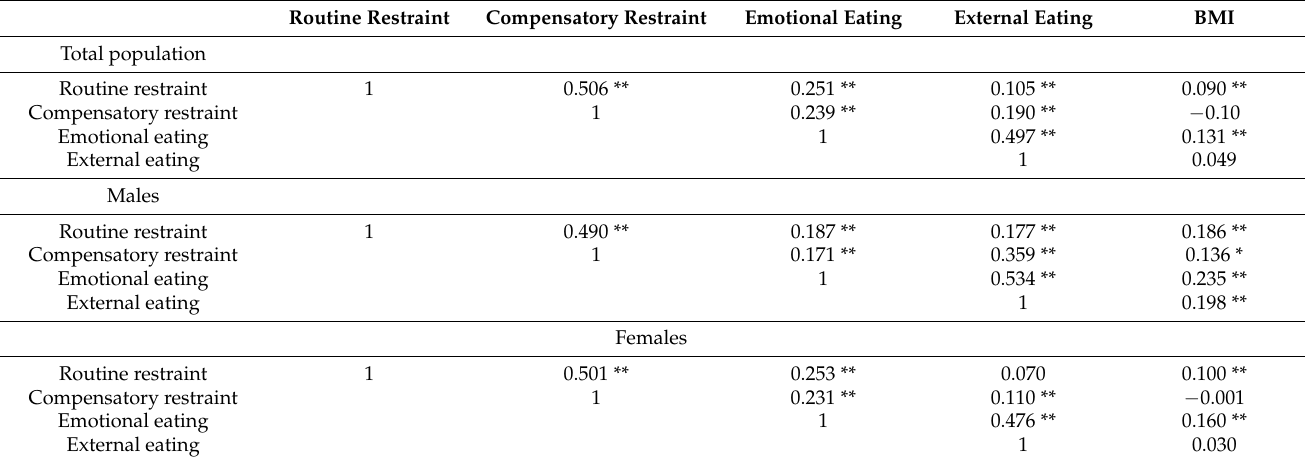
Table 3. Pearson’s correlations between psychological eating behaviors and